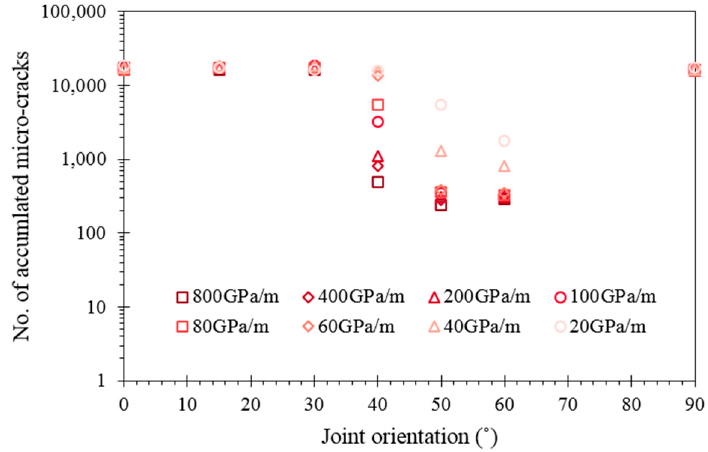
Figure 6. Accumulated number of micro-cracks with different joint normal stiffness under various joint